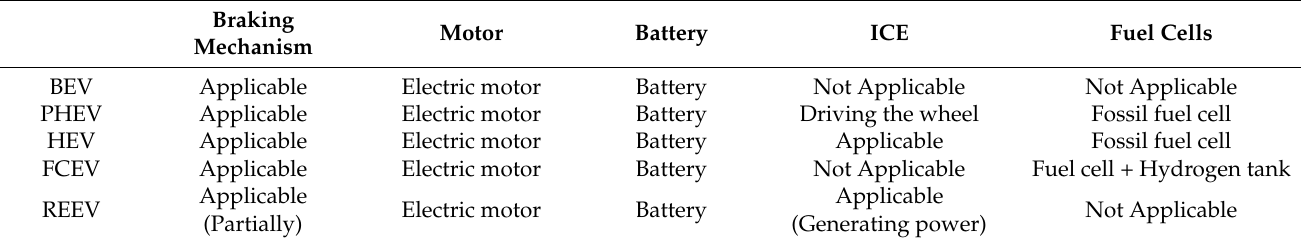
Table 1. Different types of EVs and their characteristic features